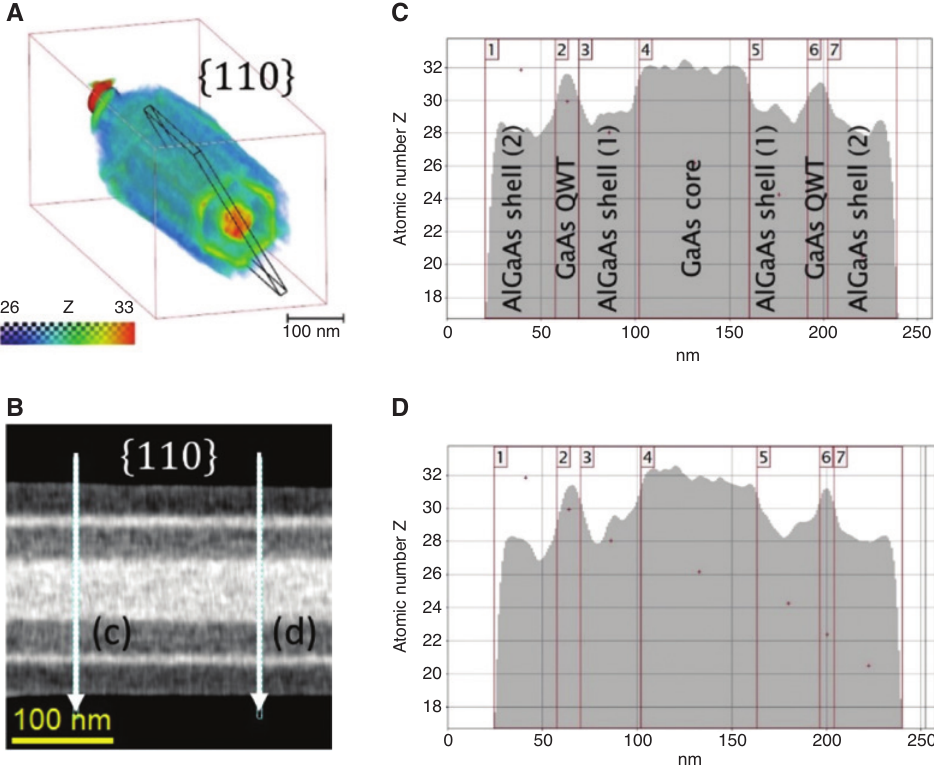
Figure 4: HAADF-STEM (Z-contrast) tomography on a GaAs-AlGaAs core-multishell nanowire. (A) 3D volume rendering of the nanowire tomogram with atomic number Z color-coded, i.e. the GaAs regions (core and QWT) are visualized as red-yellow and the AlGaAs shell as green-blue. (B) Extracted 2D slice along one [110] direction at the trunk region of the nanowire at position indicated by the black frame in (A). It shows the GaAs core and QWT in white and the AlGaAs shells in gray. (C and D) Profiles in cross-sectional direction along the line scans in (B) marked by the white arrows and their assignment to the different layers in